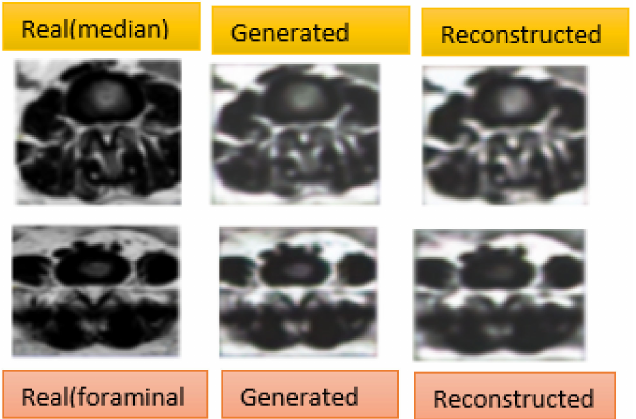
Figure 5. Generated and reconstructed images results using CycleGAN. On the left, we have the original images, in the center, we have the first generated images, and on the right, we have the second generated images which should look like the original